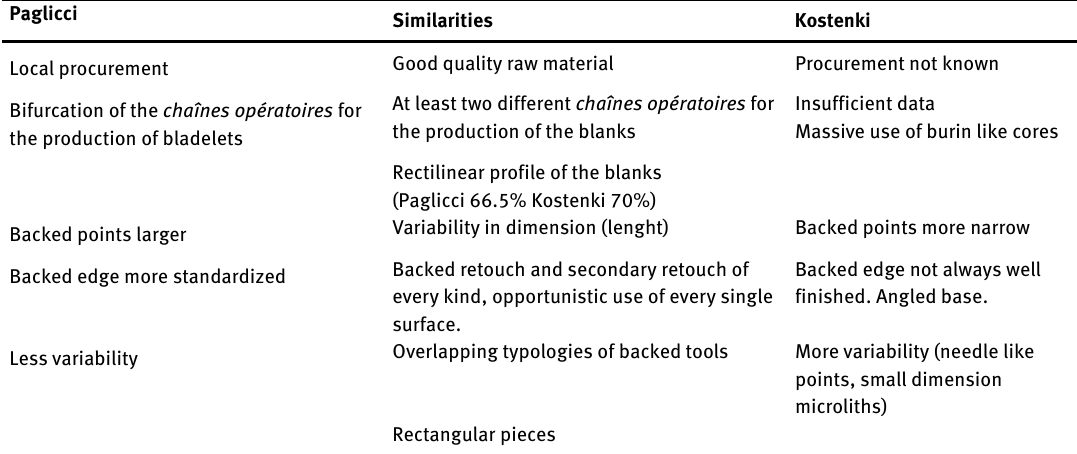
Table 1. Comparison between the backed tools of Paglicci (23–22) and Kostenki 8 (II).